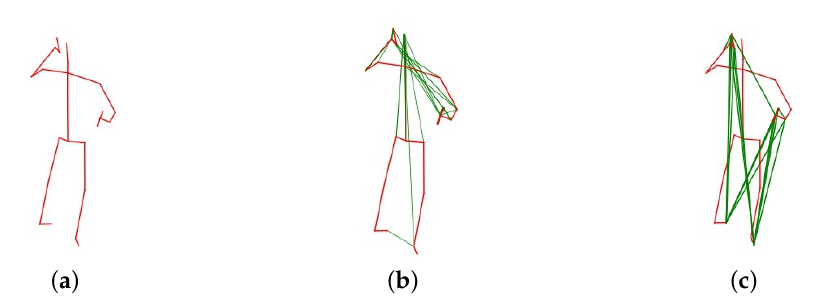
Figure 8. The visualization of the structural and action-specific edges on skeleton data. The thickness of the lines depicts the strength of relationship between two joints. The red lines denote the structural edges according to the body connection. The green lines represent the implicit edges generated by the proposed action-specific graph convolutional module; ( a ) illustrates the structural skeleton for action phone call; ( b , c ) illustrates the action-specific skeleton in layer 1 and 10 for action phone call. These two figures demonstrate the edges in different layers are